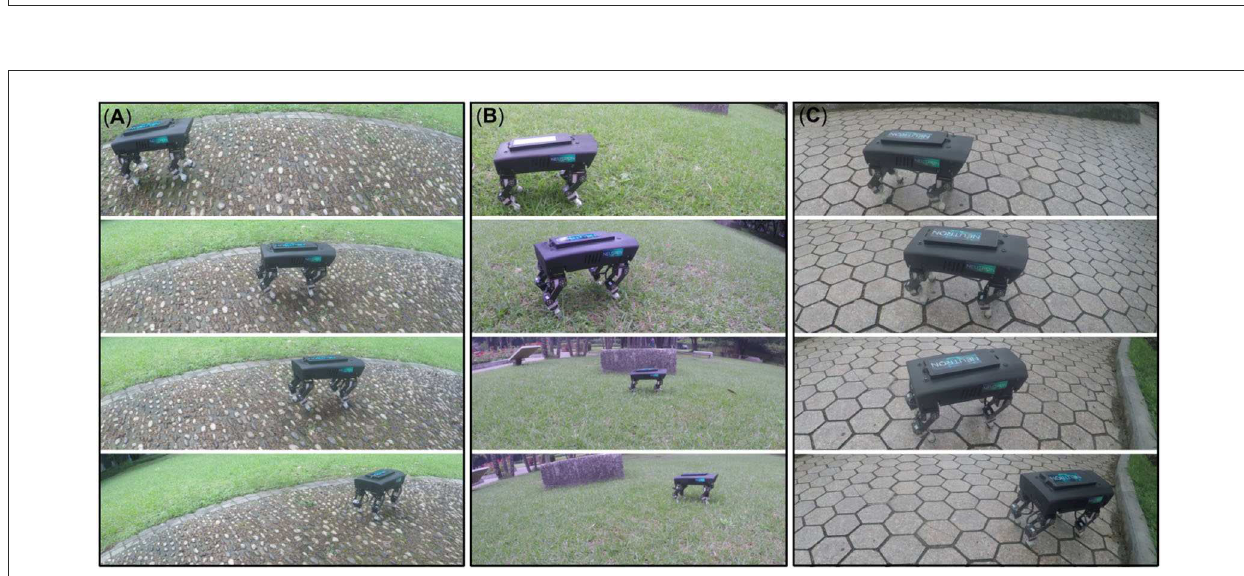
FIGURE15 Outdoor demonstration on various terrain types. (A) Gravel. (B) Grass. (C) Pavement. The formed gait was then stored through the neural couplings. This enabled maneuverability, with the robot being able to stably change its walking speed and